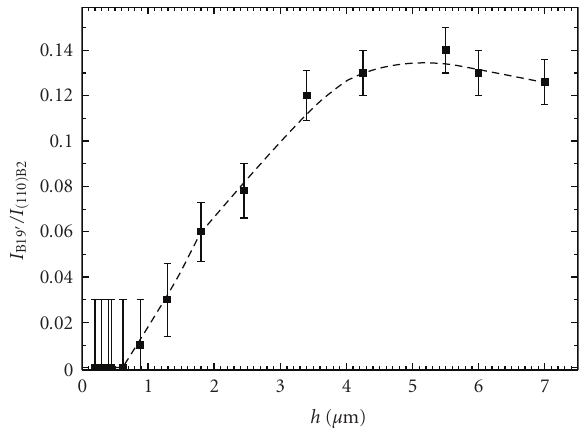
Figure 7: Ratio of the total intensity of the B19 (cid:4) peaks to the peak ( I B19 /I (110)B2 ∼ v B19 (cid:4) /v B2 ) versus the intensity of the (110) B2 penetration depth in the TiNi specimens immediately after electron beam